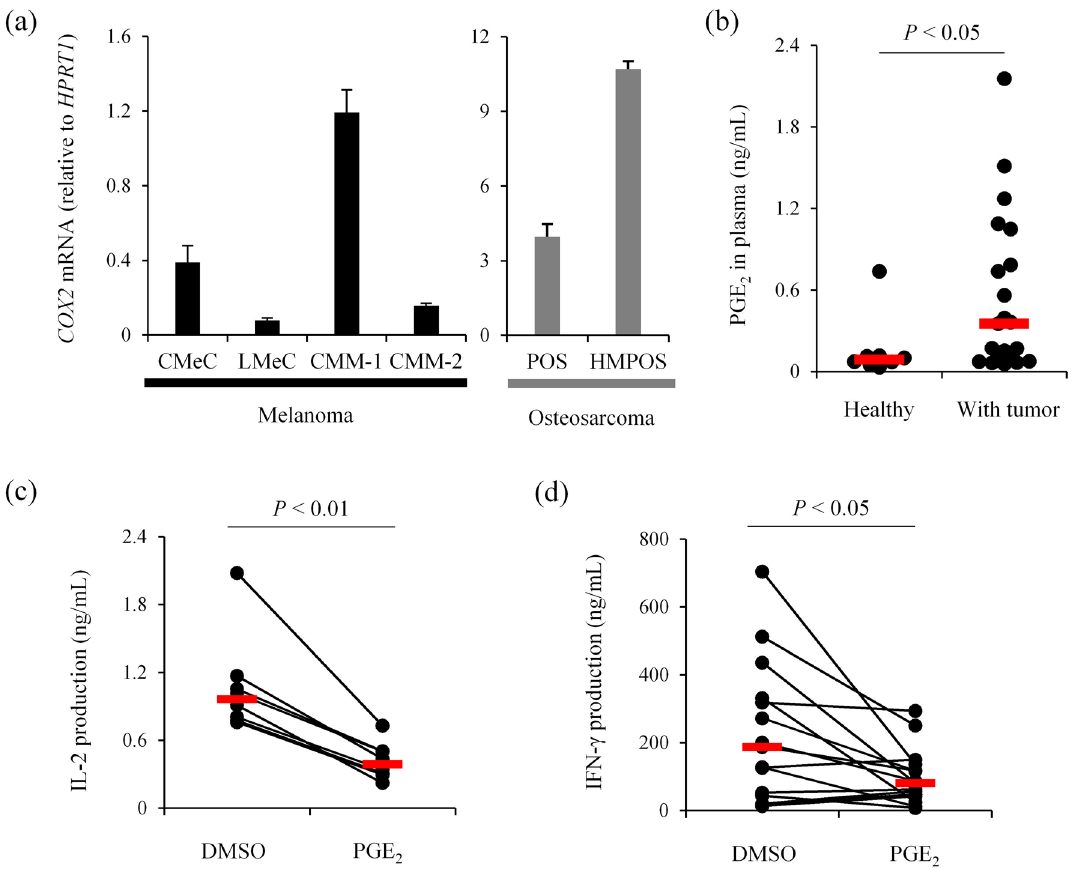
Figure 3. PGE 2 is a potential immunosuppressive factor in canine cancer. ( a ) COX2 mRNA expression in canine cancer cell lines. Total RNA was extracted from each cancer cell line and COX2 mRNA expression was measured by RT-qPCR. HPRT1 expression was used as an internal control. The mean values of triplicate measurement are shown. Error bars indicate the standard deviation (SD). ( b ) Plasma PGE 2 concentration in dogs with tumors. Plasma samples were collected from healthy ( n = 8) and tumor-bearing dogs ( n = 21). Red bars indicate the median values. Statistical analysis was performed using Mann–Whitney U test. ( c , d ) Suppression of cytokine production from canine peripheral blood mononuclear cells (PMBCs) by PGE 2 . Canine PBMCs were cultured for 3 d with or without 2.5 μM PGE 2 , and concentrations of ( c ) IL-2 ( n = 7) and ( d ) IFN-γ ( n = 15) in the supernatant were measured by ELISA. Red bars indicate the median values. Statistical analysis was performed using Wilcoxon signed rank